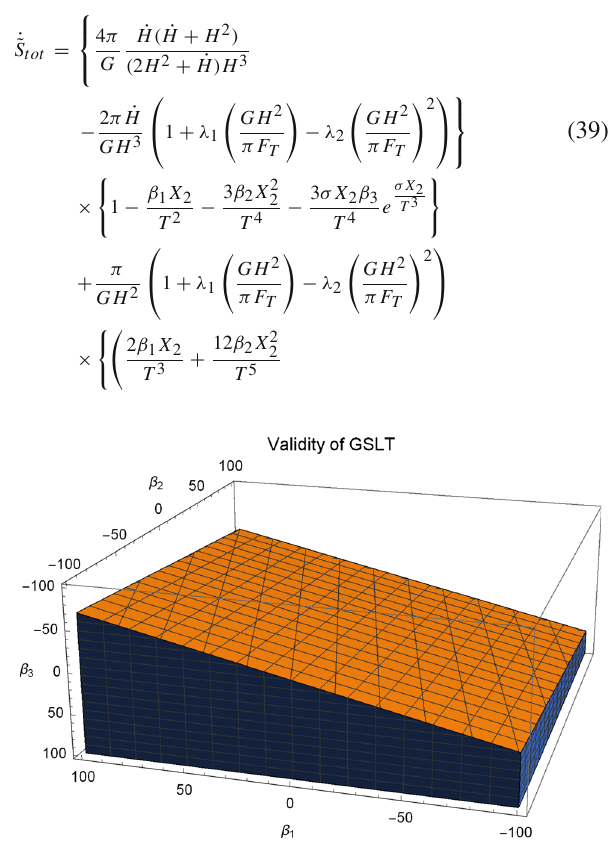
Fig. 4 The plot represents the validity regions for GSLT constraint in terms of cosmographic parameters for the model (34)